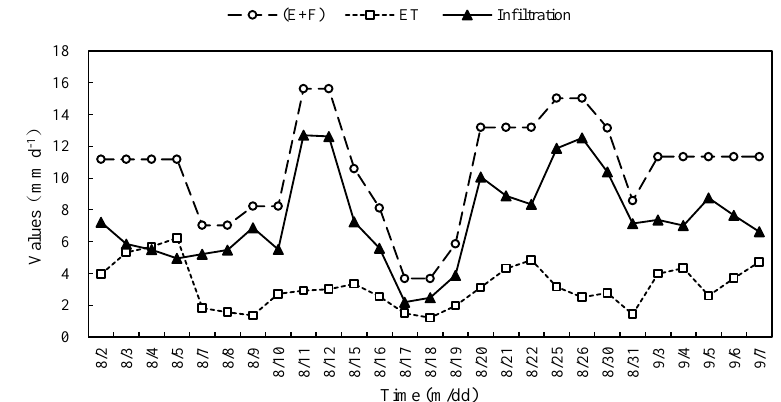
Figure 2. Schematics of ( E + F ), ET c and infiltration of the paddy field.